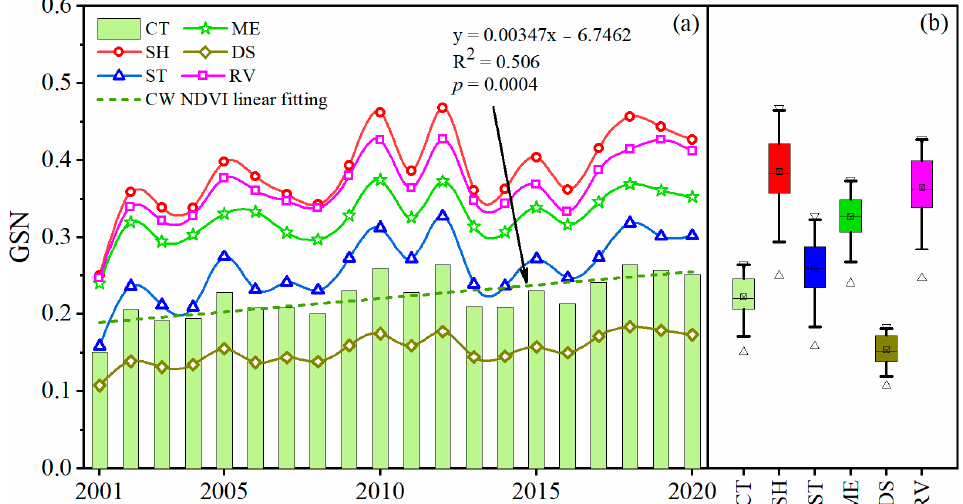
Figure 3. ( a ) Yearly changes in growing season NDVI (GSN) of Wulan County and each vegetation type in Wulan County from 2001 to 2020; ( b ) Distributions of GSN values from 2001 to 2020. CT, SH, ST, ME, DS, and RV represent county, shrubland, steppe, meadow, desert steppe, and rest vegetation, respectively. Table 1. Changing trend classification of growing season NDVI for different vegetation types from